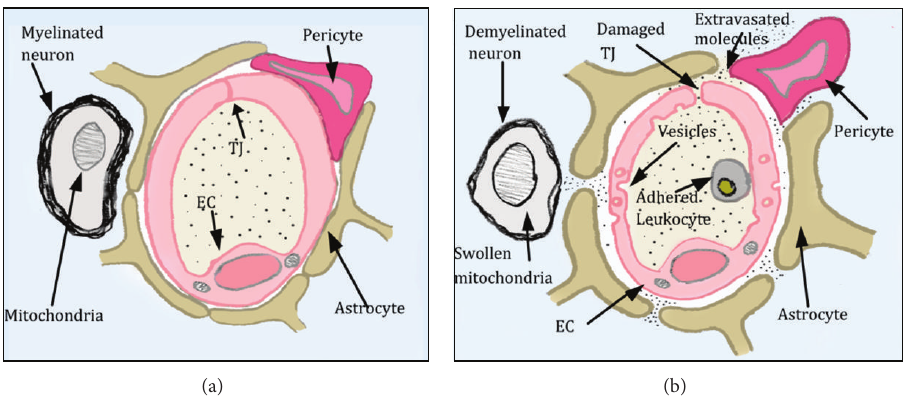
Figure 4: This diagram depicts a cross section of brain parenchyma showing the structure of the BBB and the damage induced by RT. (a) NormalBBBshowingintacttightjunctions(TJ),lackofvesicles,astrocytesandpericytesabuttingtheECprovidingadditionalbarriersupport, and a neuron with thick, healthy myelin. (b) Damaged BBB in which astrocytes and pericytes have pulled away from the EC, a leukocyte has adhered to the EC, and there is formation of vesicles and loss of TJ